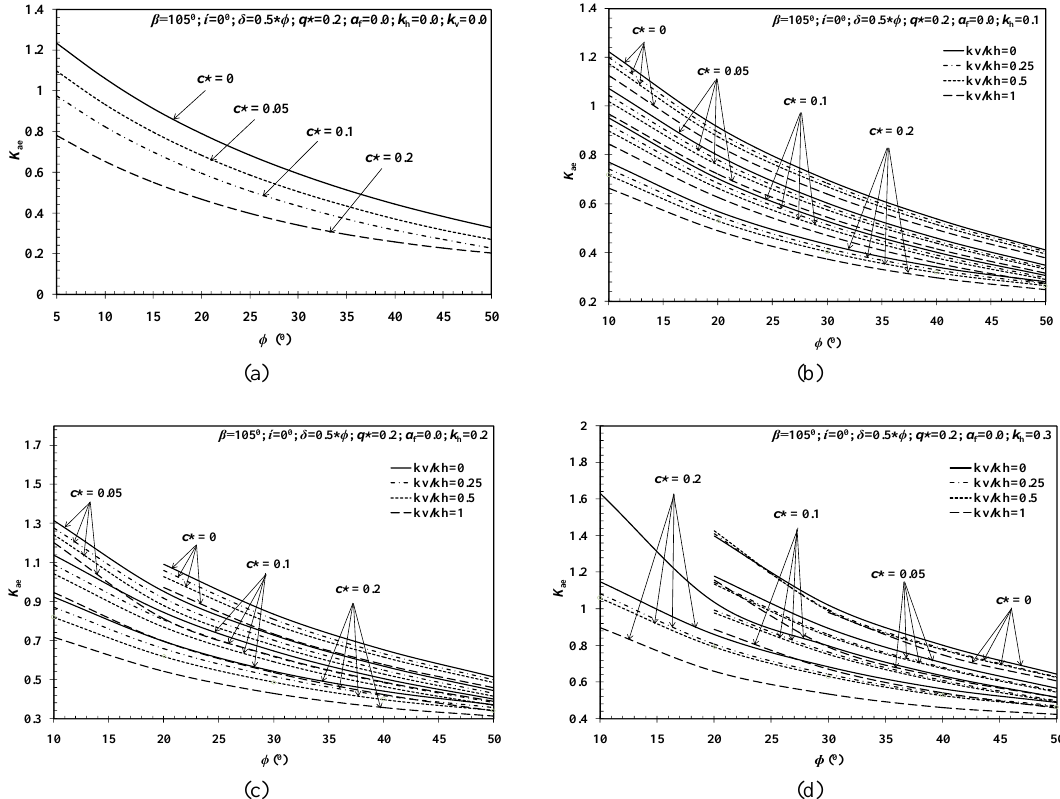
Figure 3. Design charts for K ae for backfill slope i = 0 o and wall inclination β = 105 o